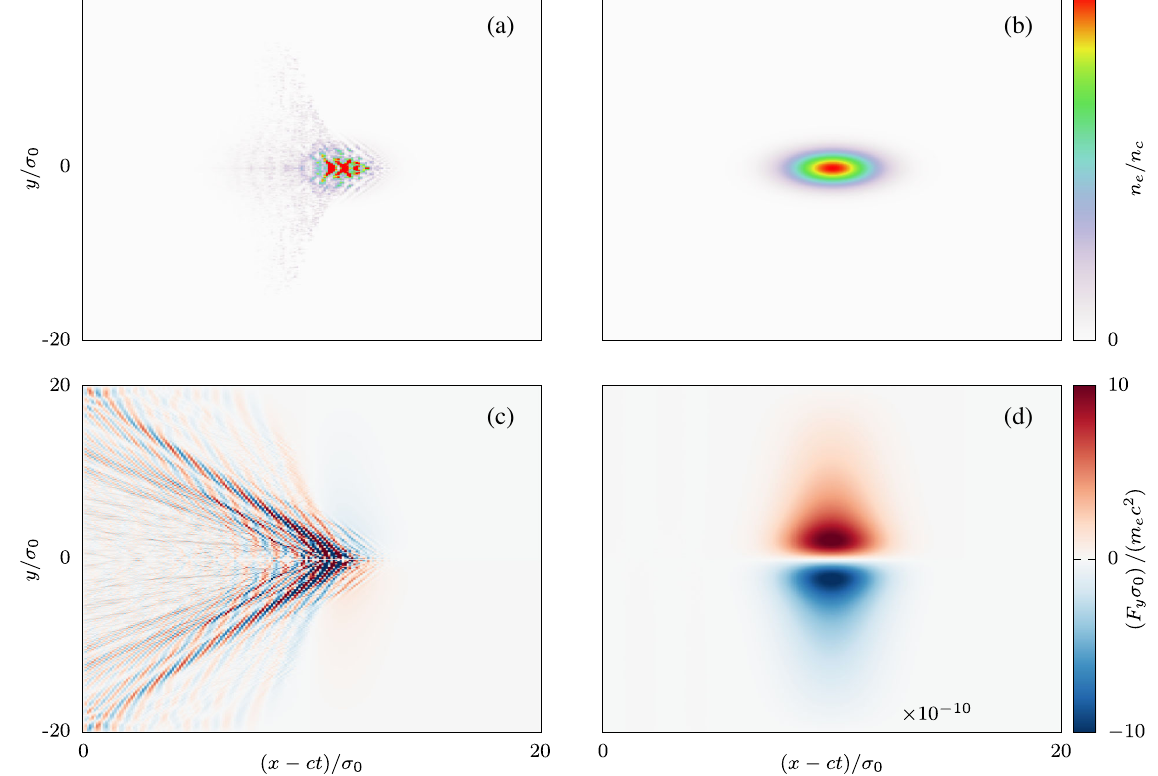
FIG. 1. Ultrarelativistic electron bunch propagating in vacuum without RR. Data for electron density [see (a) and (b)] and transverse force [see (c) and (d)] are shown at time t=T b ¼ 10 . (a) and (c) show the results for the Yee solver, while (b) and (d) show the results for the RIP scheme. It is further noted that the data in (d) are scaled in order to apply the same color